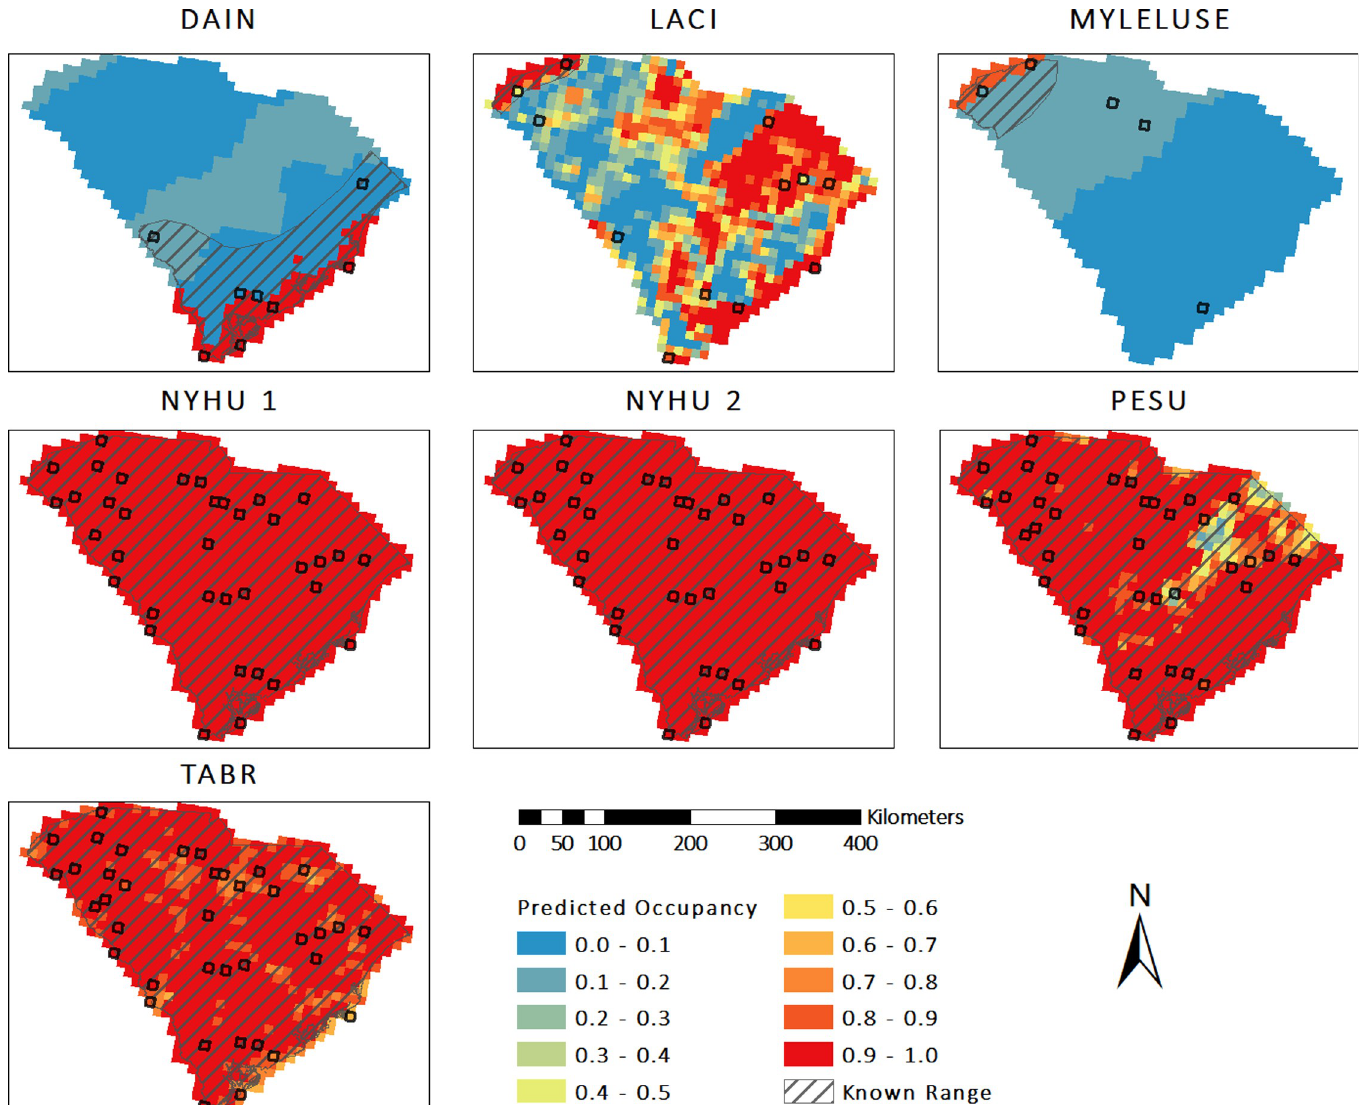
Fig 5. Predicted distribution maps for bat species across South Carolina. Distributions are based on effect estimates in the top-ranked occupancy model for each species, if non-null, and measures of environmental covariates in each cell. Black-outlined squares indicate cells where species were detected in 2015, 2016, or both years. Known summer ranges are based on Menzel et al. [43]. Refer to Table 1 for species code